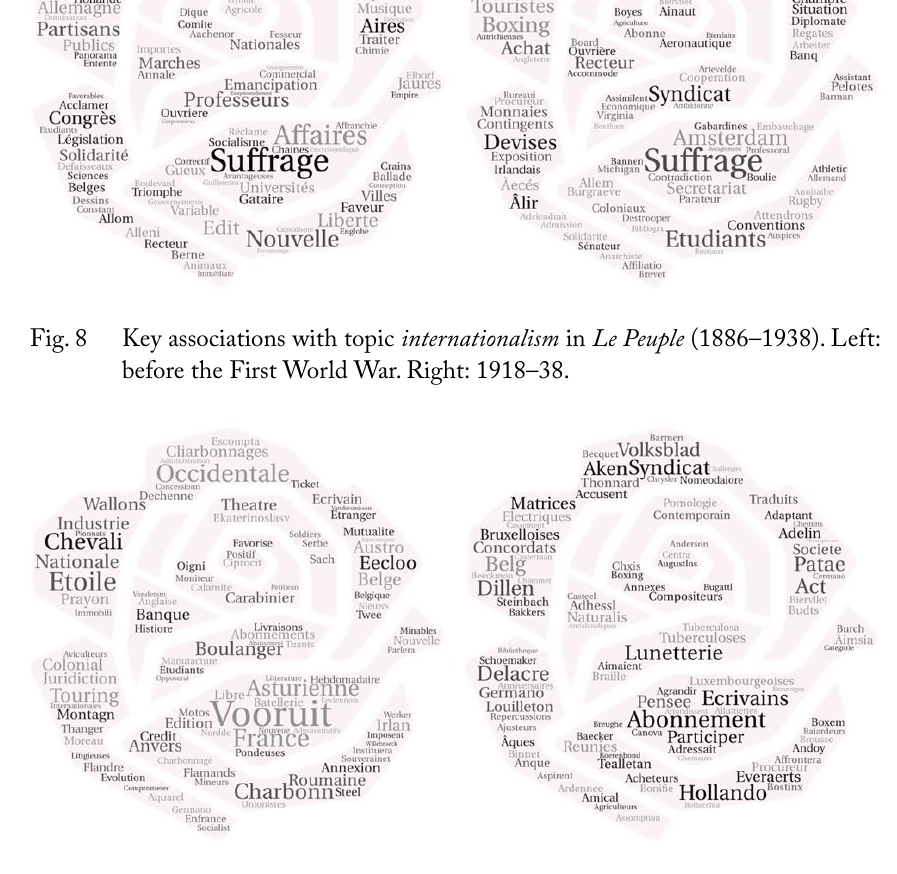
Fig. Figure 9: Key associations with topic nationalism in Le Peuple (1886-1938). Left: before WW 1. Right: 1918- 1938.